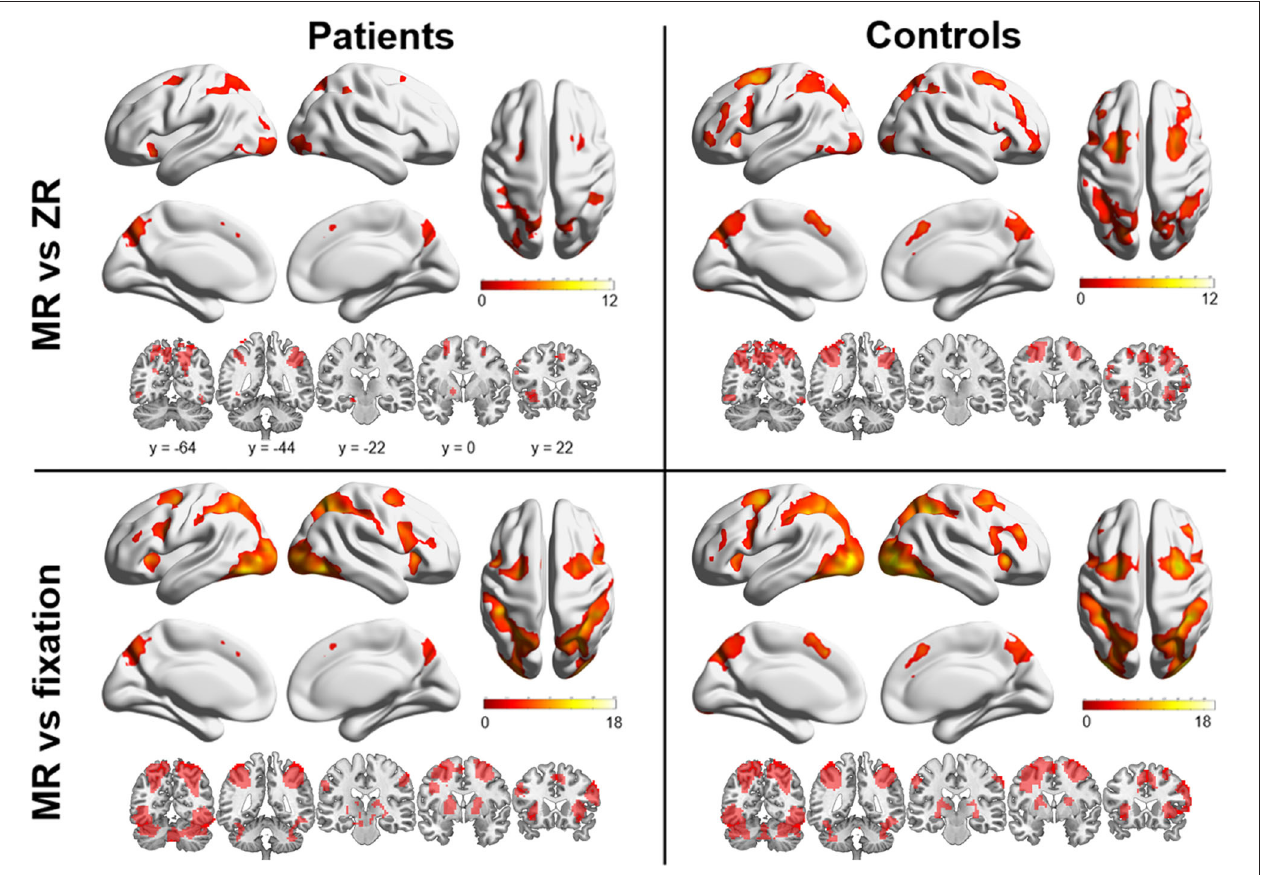
FIGURE 2 | Brain regions are shown that were significantly activated in patients with OCD and healthy controls (HCs) during the mental rotation (MR) condition vs. the zero rotation (ZR) condition and in the MR condition vs. the fixation condition. Markedly increased activation was observed in the frontal and parietal areas in both